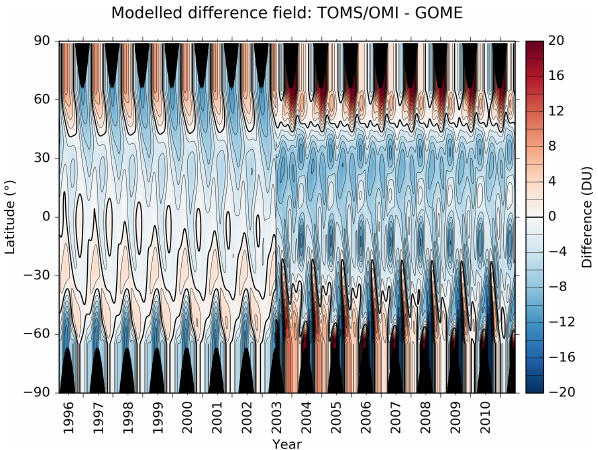
Figure 3. The results obtained by fitting Eq. (1) to the differences between corrected TOMS/OMI TCO zonal means and GOME TCO zonal means. An additional basis function is included to account for the 22 June 2003 anomaly. Regions shaded in black denote the polar night where space-based measurements in the UV–visible part of the spectrum are not possible. The thick black line denotes the zero